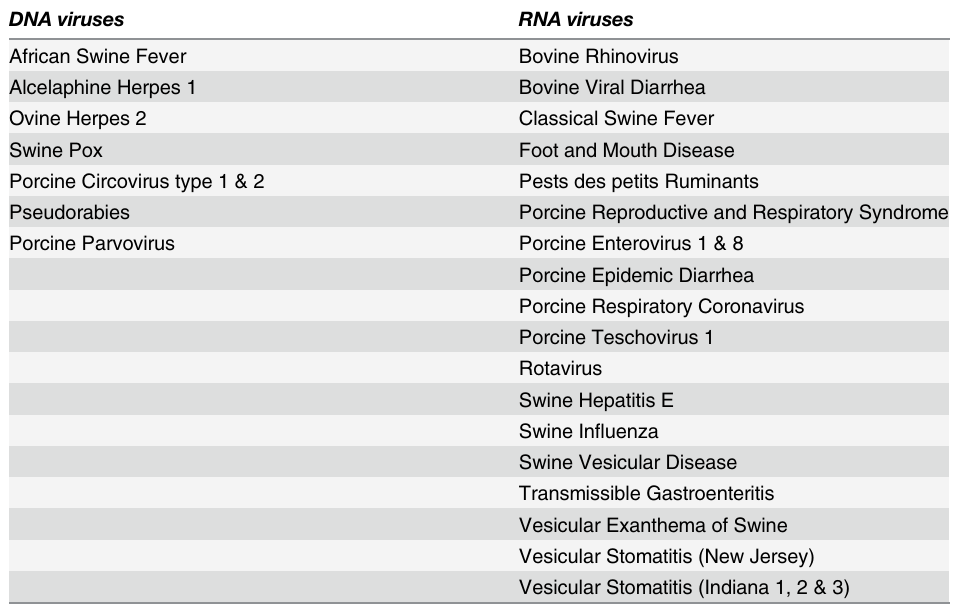
Table 1. Viruses tested by SV-A RT-qPCR